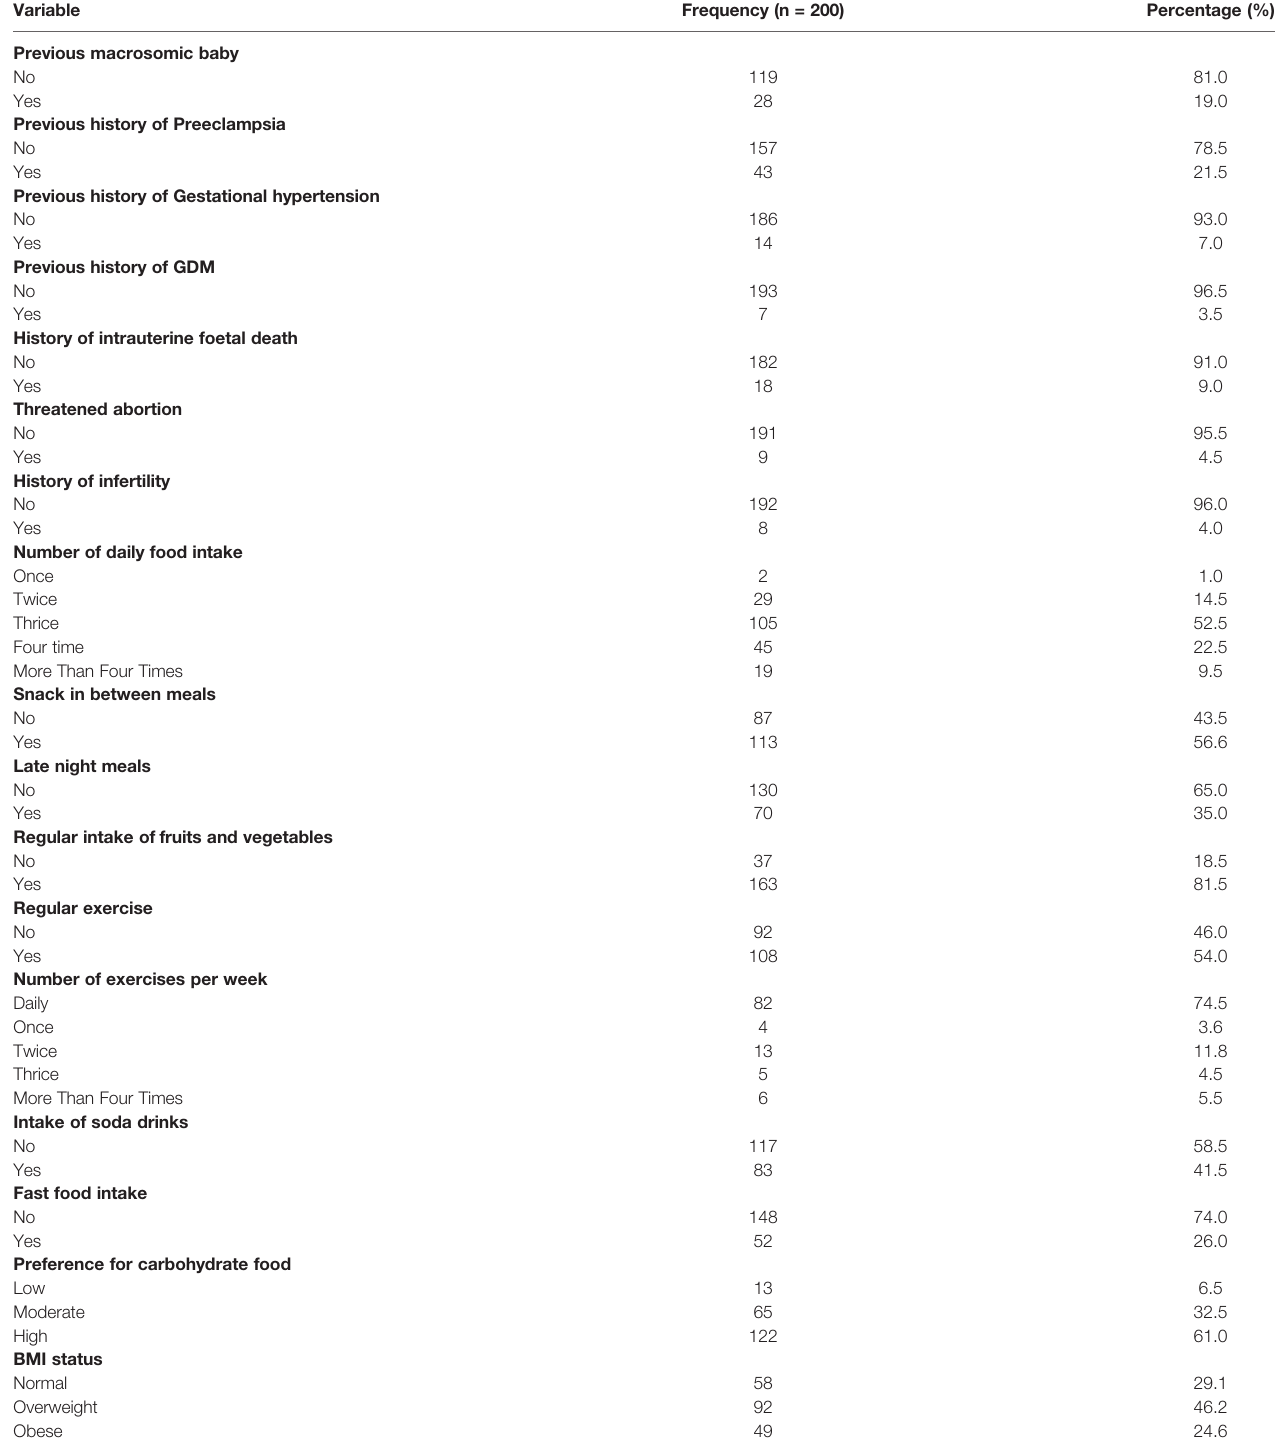
TABLE 2 | Baseline characteristics on clinical and lifestyle